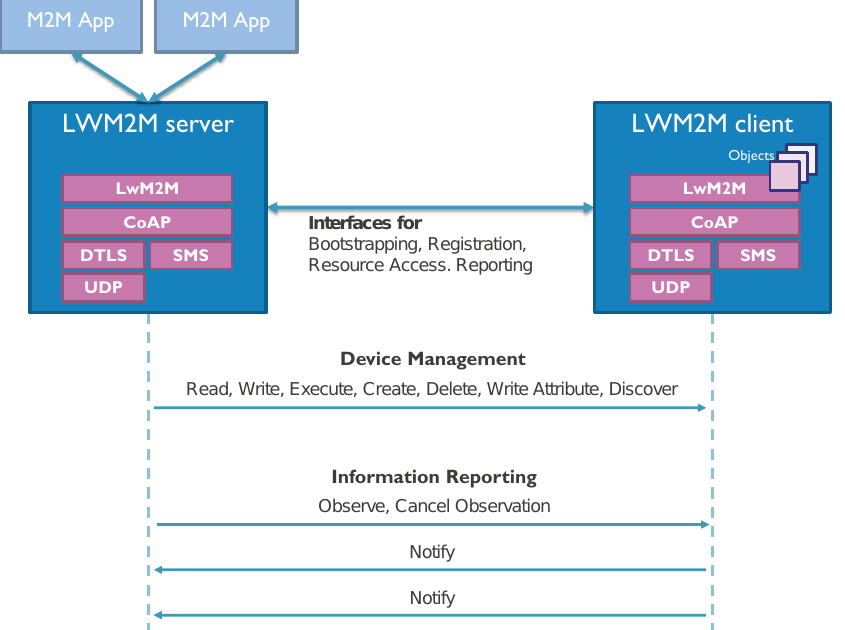
Figure 1. Open Mobile Alliance (OMA) LwM2M interaction